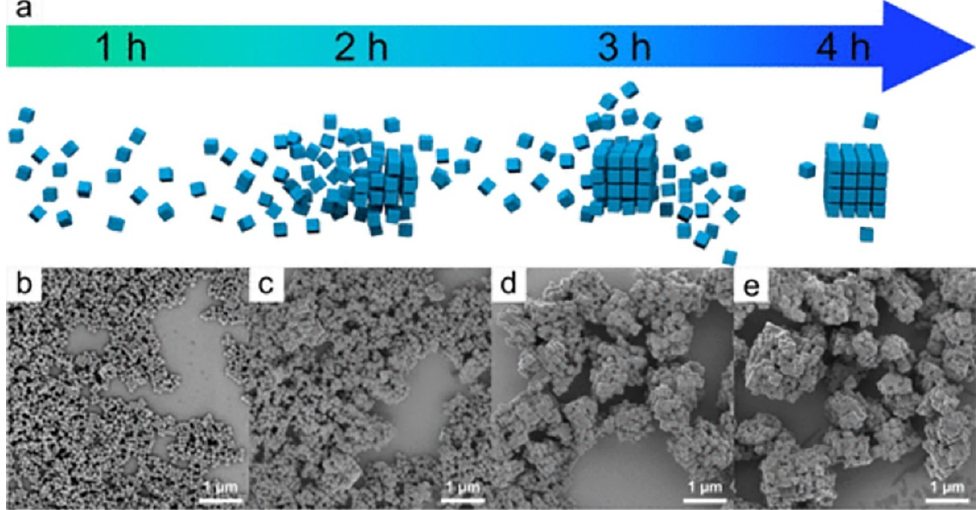
Figure 12. ( a ) Schematic illustration of the time-dependent alignment of nickel hexacyanoferrate nanoparticles. SEM image of the nickel hexacyanoferrate mesocrystals formation. ( b ) 1 h, ( c ) 2 h, ( d ) 3 h, ( e ) 4 h. The figure is reproduced with copyright permission of ref. [89].